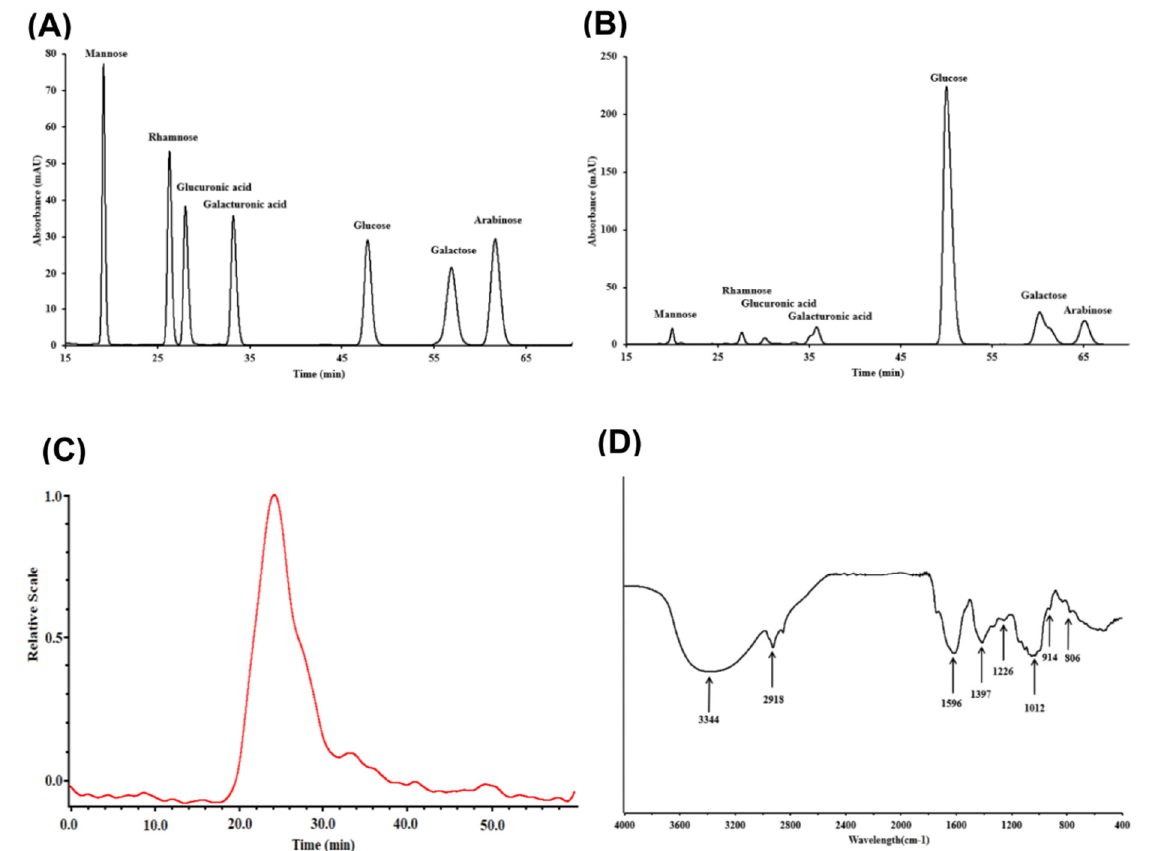
Figure 1. Characterization of AVLP. ( A ) HPLC chromatogram of a mixed solution of standard monosaccharides; ( B ) HPLC chromatogram of AVLP; ( C ) Molecular weight distribution of AVLP; ( D ) FT-IR spectrum of AVLP.